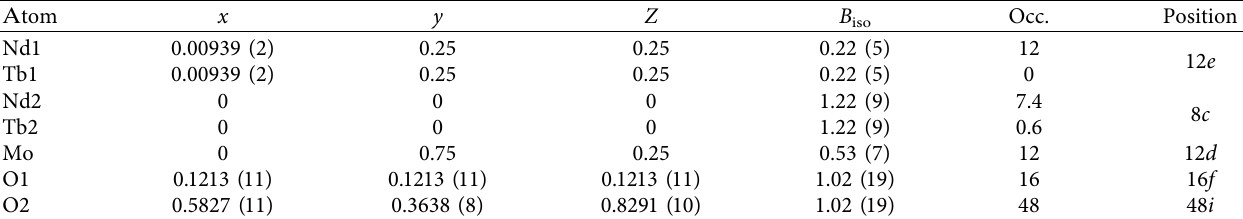
Table 4: Refned coordinates and isotropic thermal parameters of atoms, as well as the occupancy of positions of Nd solution.